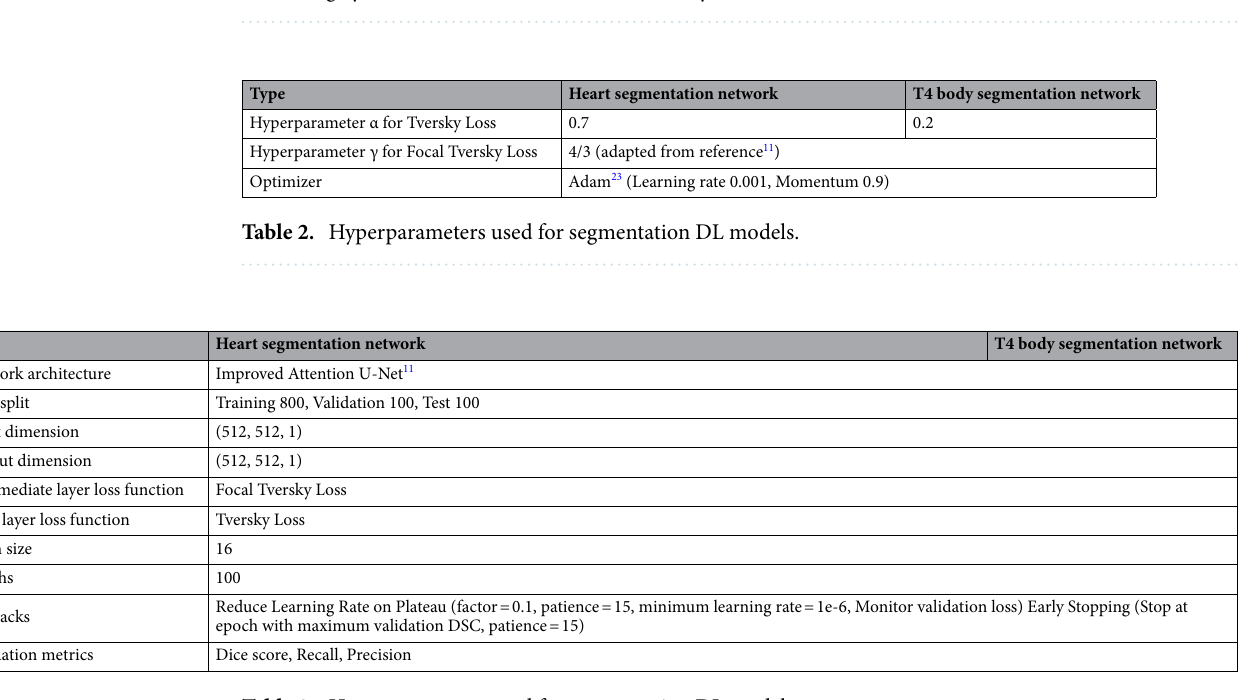
Table 3. Hyperparameters used for segmentation DL